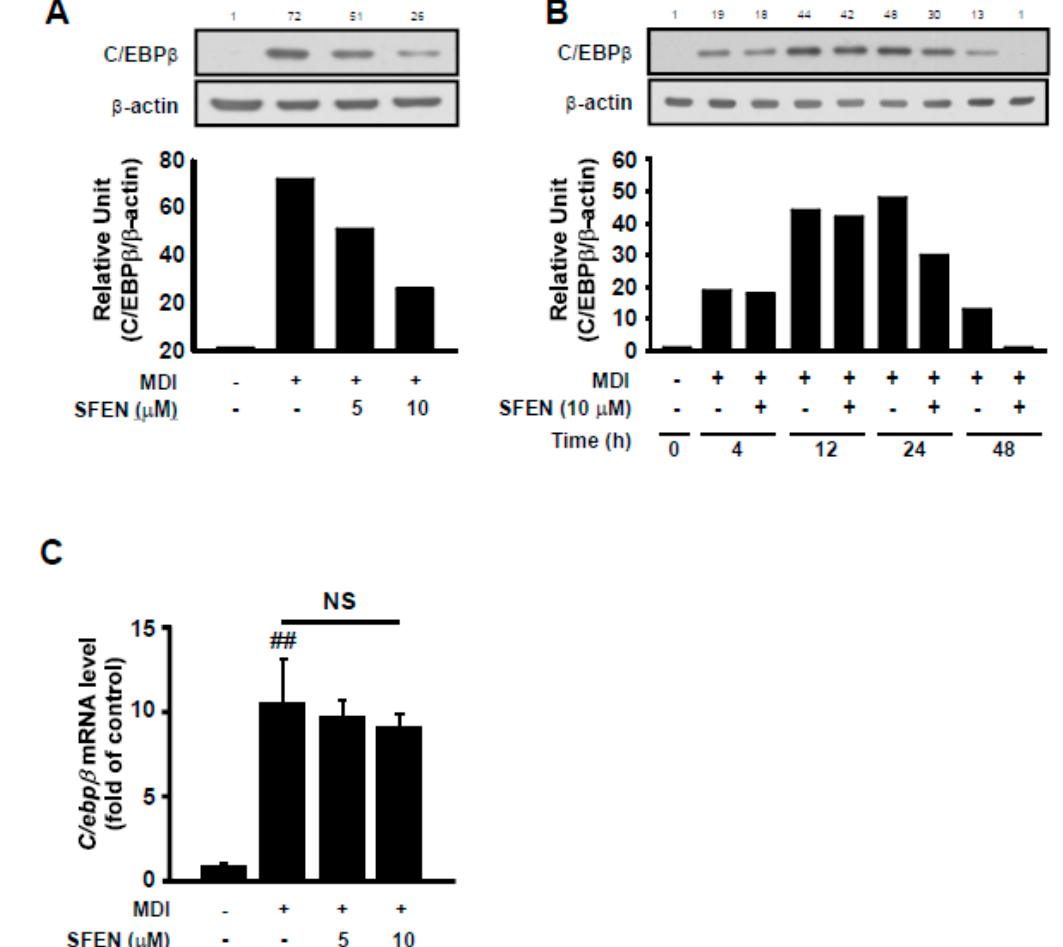
Figure 4. E ff ect of sulforaphene (SFEN) on di ff erentiation medium-induced C / EBP β expression in 3T3-L1 pre-adipocytes. ( A ) Western blot analysis indicated that SFEN attenuated the protein expression levels of C / EBP β (35 kDa) and β -actin (43 kDa) as housekeeping gene in a dose-dependent and ( B ) time-dependent manner. ( C ) The gene expression levels of C / ebp β and β -actin as housekeeping gene in 3T3-L1 pre-adipocytes were determined using real-time PCR. 3T3-L1 pre-adipocytes were seeded in 6 cm dishes at a density of 0.75 × 10 4 cells per cm 2 . Confluent cells were incubated for two days in mouse adipocyte di ff erentiation medium (MDM) with or without SFEN at a concentration of 5 or 10 µ M. ( A , C ) At 48 h and ( B ) 4, 12, 24, and 48 h after the addition of MDM, ( A , B ) the cells were harvested by using 80 µ L of RIPA bu ff er per dish to prepare samples for western blotting to determine the expression level of C / EBP β . 40 µ g of protein was loaded per lane on 10% gel. ( C ) The mature adipocytes were harvested for qPCR and 1 µ g of RNA was used for the synthesis of cDNA. Data were obtained from three independent experiments. For Figure 4B, similar data were obtained from an independent repeated experiment. Data are expressed as the means ± standard deviation ( n = 3). ##, significant di ff erence between the control and the MDM control by ( p <